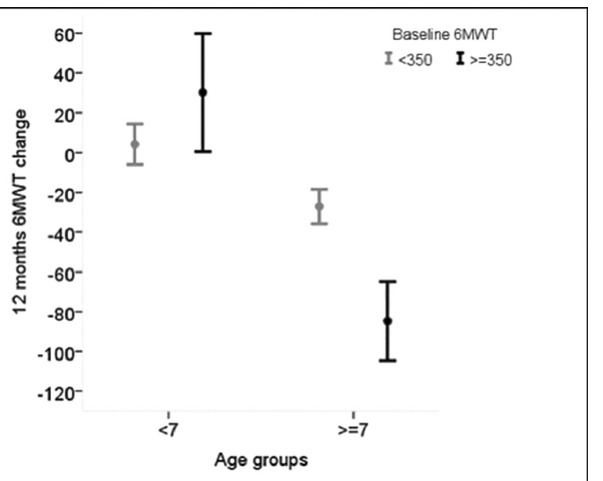
Fig 3. Average 6MWD change over 12 months according to baseline age ( < 7 years vs > = 7 years) in those with baseline 6MWD < 350 m and in those with baseline 6MWD > = 350 m. The significant age by 6MWD interaction (p < 0.001) indicates that the baseline value of 6MWD has an impact on the 6MWD change only in children older than 7 years.